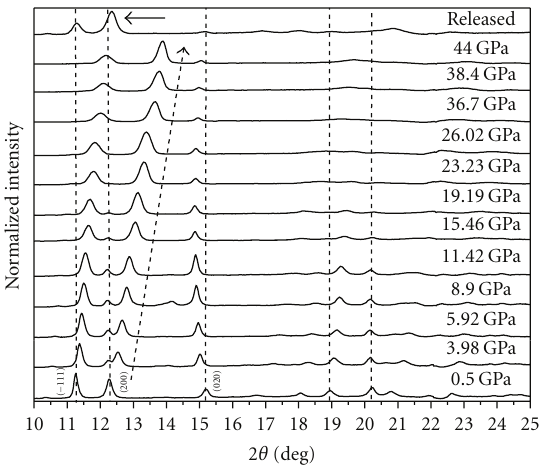
Figure 6: The XRD pattern of the 2% Fe-doped bulk CuO sample at di ff erent pressures using synchrotron radiation of wavelength 0.4564 ˚A.